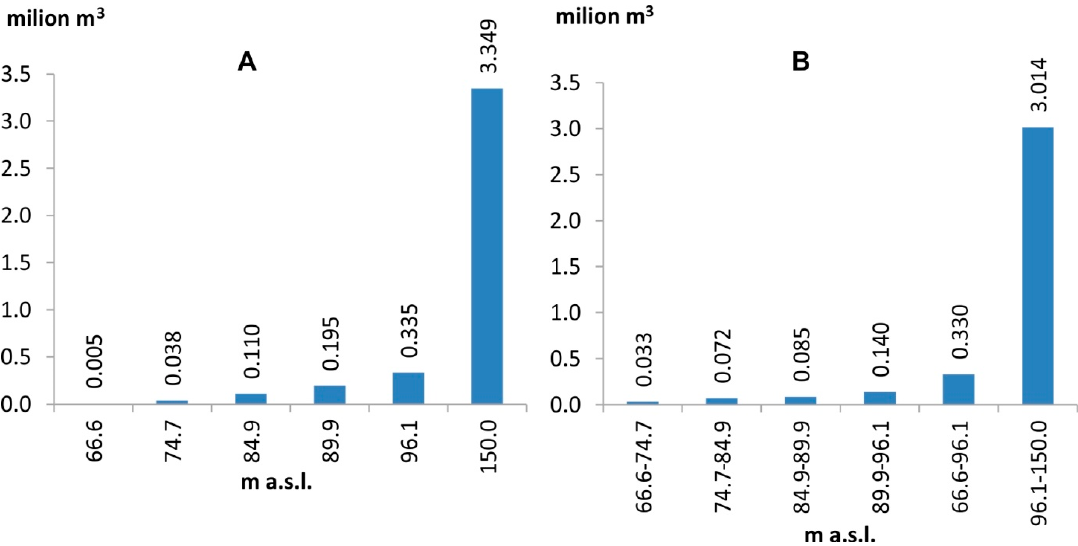
Figure 3. Volume of water in the quarry lake at a specific water level ordinate ( A ) and between water level ordinates ( B ).